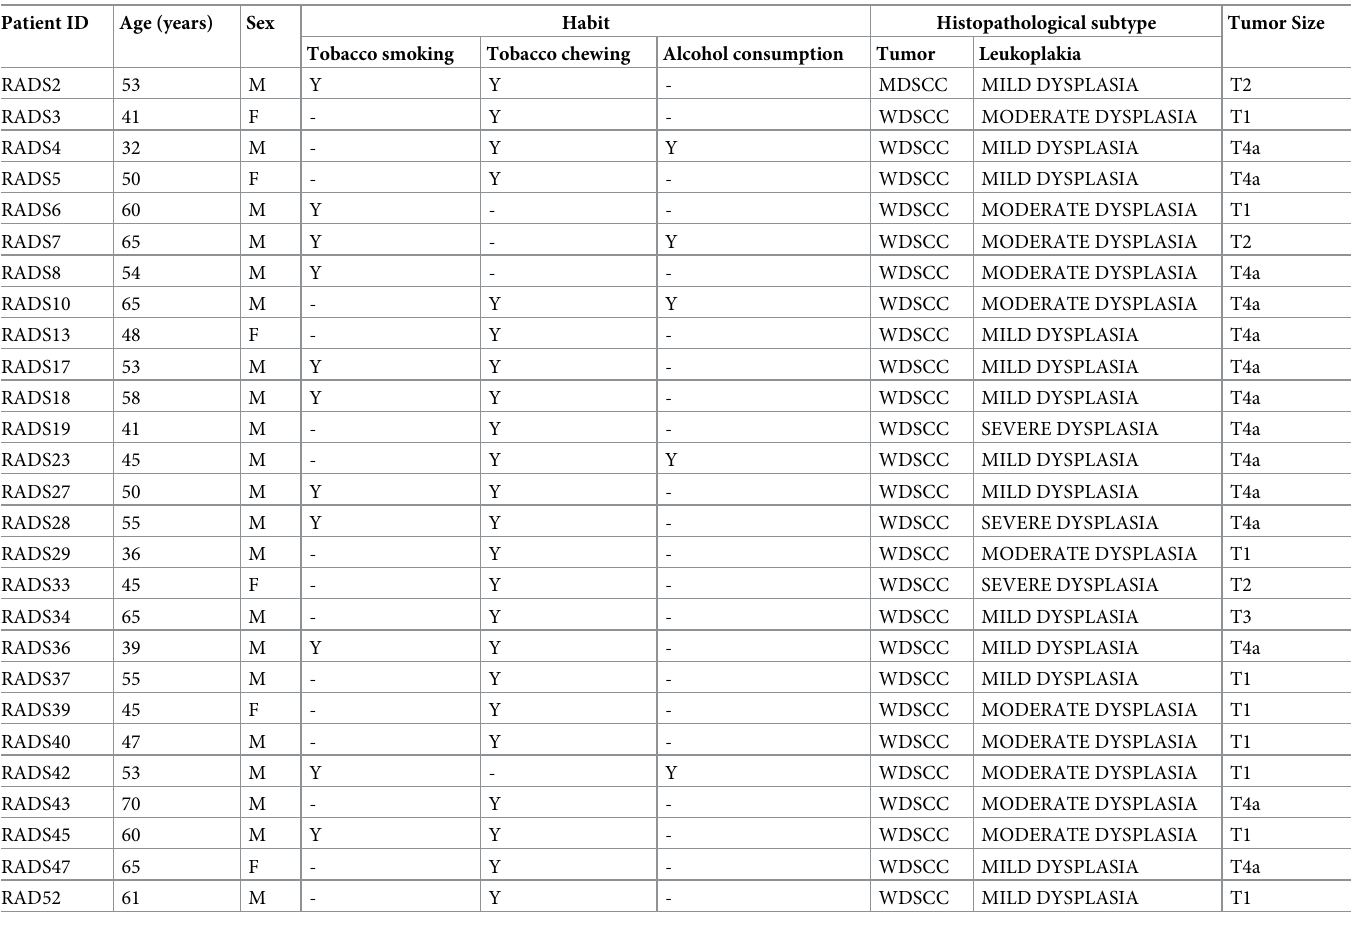
Table 1. Demography of patients with tobacco habits and histopathological observations (n = 27).